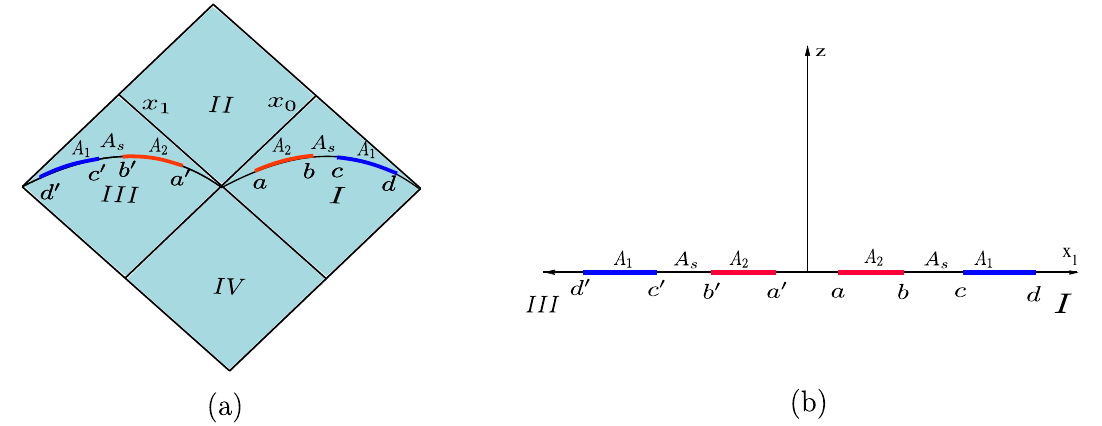
Figure 5 . (a) Two disjoint intervals A 1 (blue) and A 2 (red) on the Rindler wedges I and III respectively of the Minkowski diamond. (b) These two intervals are projected on the x 1 - z plane of the Poincar´e